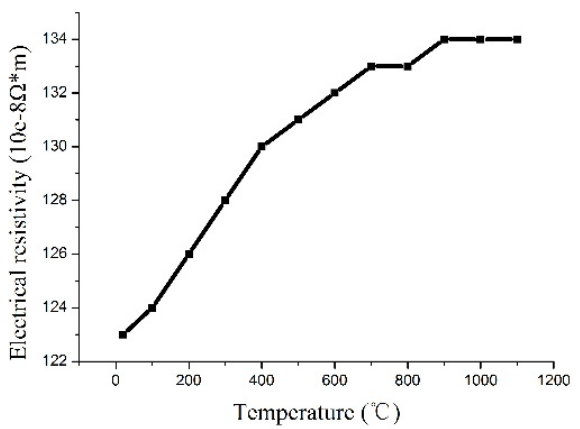
Figure 8. Electrical resistivity of Inconel 718.